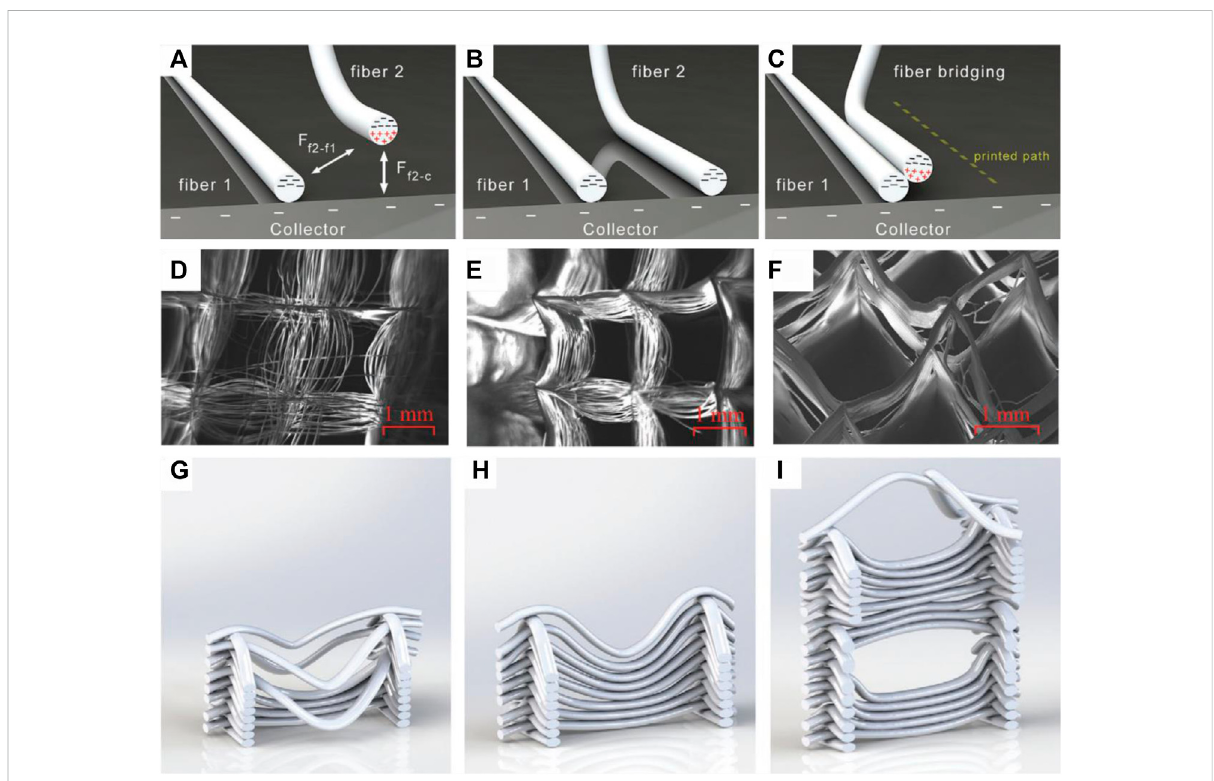
FIGURE 3 Fiber displacement caused by fi ber attraction (A – C) (Kim et al., 2021) and fi ber repulsion caused by collector temperature (D – I) (Nguyen et al., 2019):Whileairborne,electrostaticattractiveforcesareexertedfromalreadydeposited fi bersaswellasfromthecollectoronnewlyformed fi bers (A) . When the attracting effect of the collector dominates or inter fi ber distance is large enough, the correct fi ber deposition occurs (B) . If the inter fi ber distance is small enough, the attracting forces of already deposited fi bers are large enough to affect the fi ber deposition of the newly formed fi ber (C) .Fiberrepulsionindependencyofthecollectortemperaturewithalowtemperature(16 ° C) (D,G) ,roomtemperature(23.5 ° C) (E,H) andahigh collector temperature (30 ° C) (F,I)